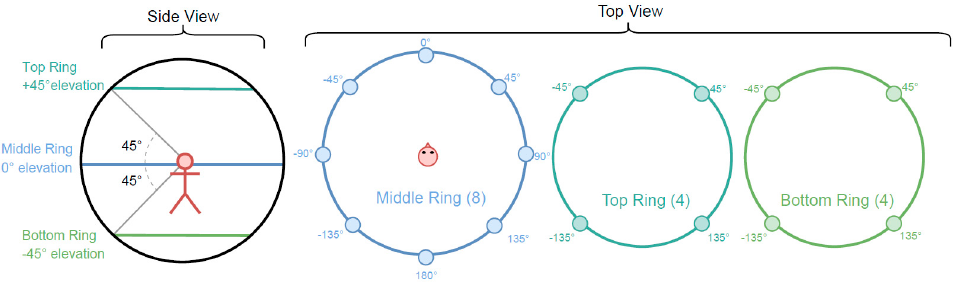
Figure 4. Side and plan view schematics of the loudspeaker array layout. Shaded circles denote the loudspeaker locations and the labels indicate the azimuthal angle of the speaker (taken from